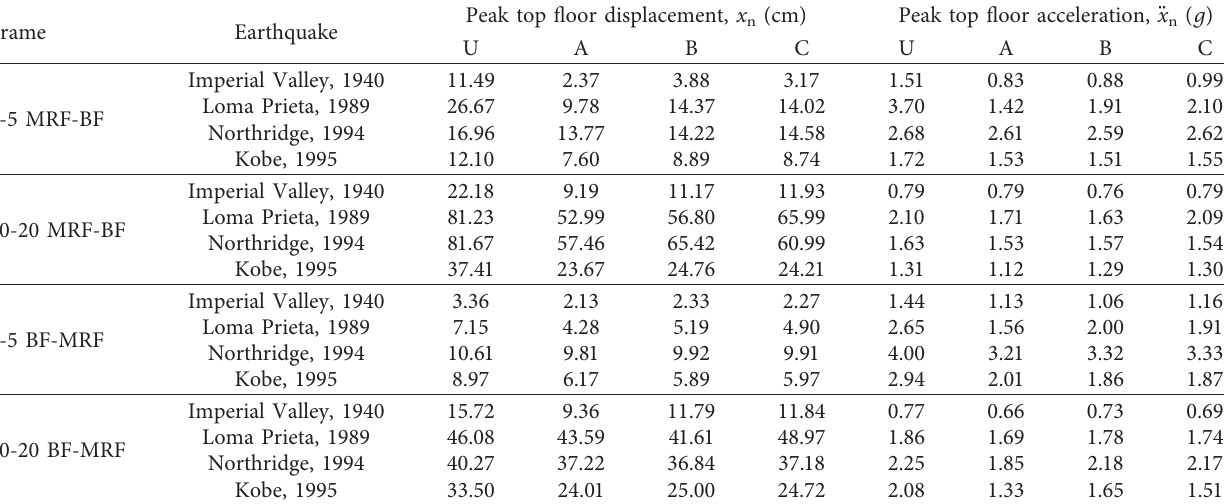
Table 8: Peak top floor displacement and acceleration responses of dissimilar connected buildings for equal storey height under historical earthquake ground motions.